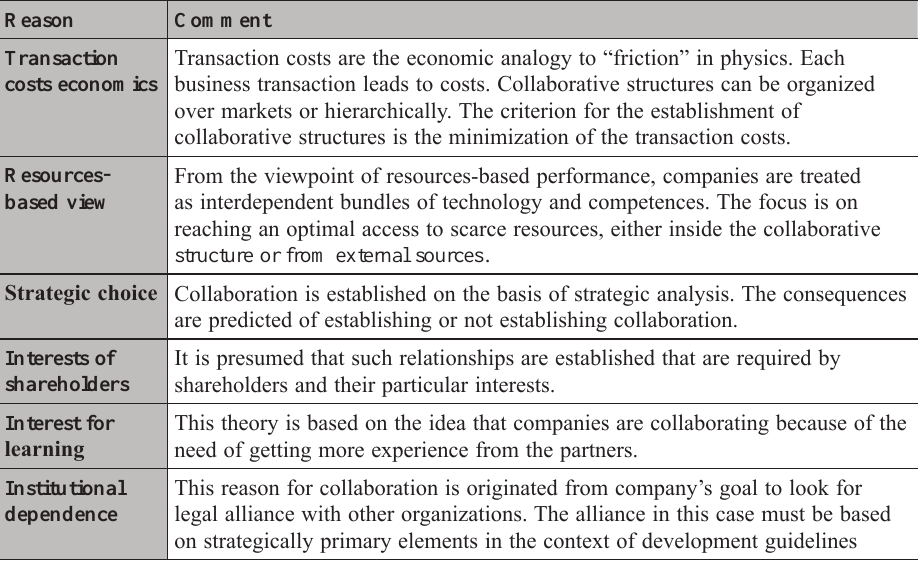
Table 1. Reasons for companies’